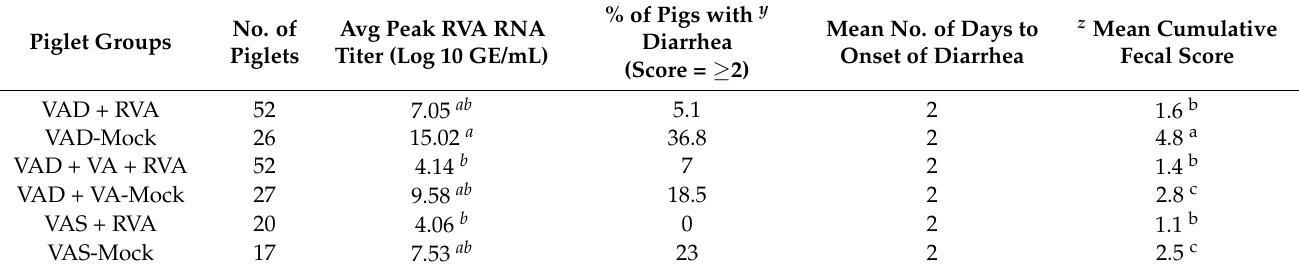
Figure 3. Average normalized piglet body weight change from birth to RVA Post Challenge Day (PCD) ~12 ( a ), RVA RNA shedding was determined by RT-qPCR and expressed as log 10 GE/mL. Viral RNA shedding in piglets was measured at PCD0–12 ( b ), and sows RV RNA shedding post-sow inoculation and post-piglet challenge ( c ). a , b , and c represent significant differences among the groups ( p ≤ 0.05). Table 1. Piglet diarrhea and RVA RNA peak shedding